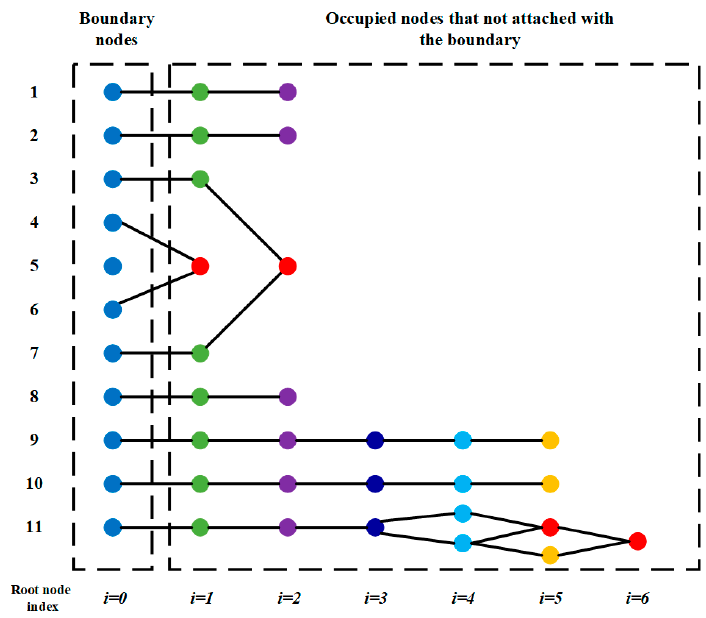
Figure 10. The hieratical relationship between the root nodes and the child nodes for the example in Figure 9. The child nodes generated from the same root node will be collapsed at that root node. The child node that has several parent nodes (in red) will be deformed into the middle position of the trajectory generated by its all parent nodes along the